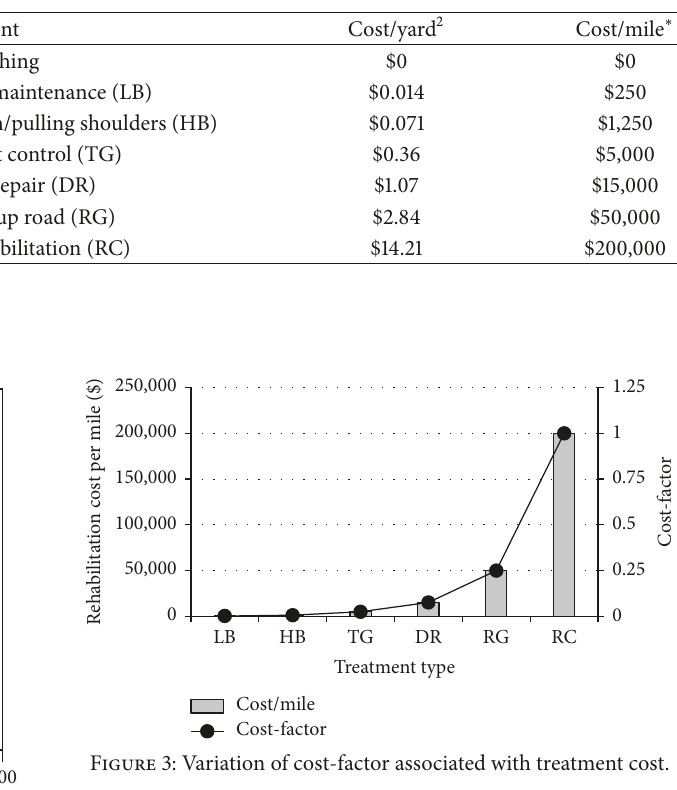
Table 1: County unpaved road treatment decision process.